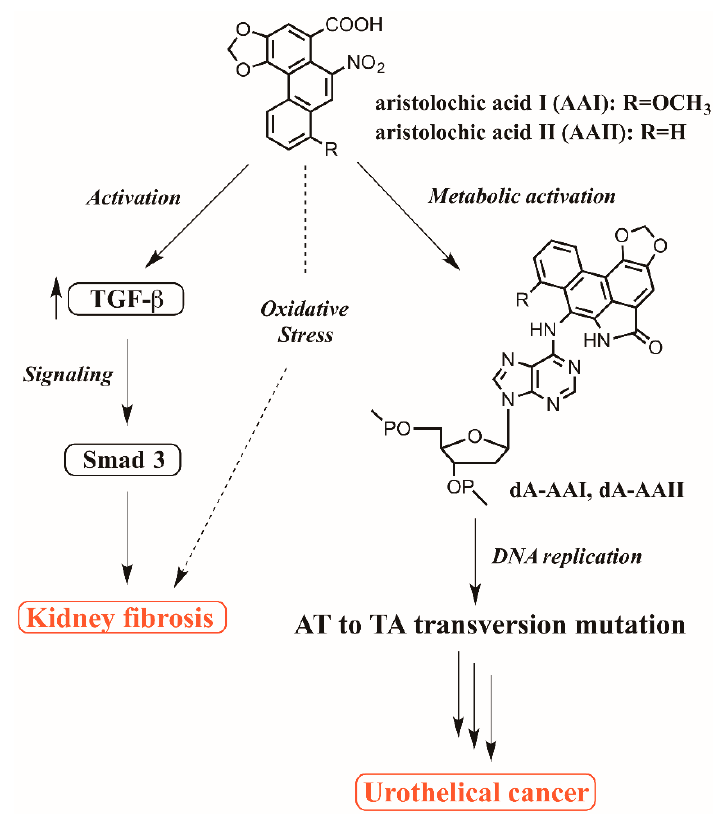
Figure 1. Postulated mechanisms for the nephrotoxicity and carcinogenicity of aristolochic acids.